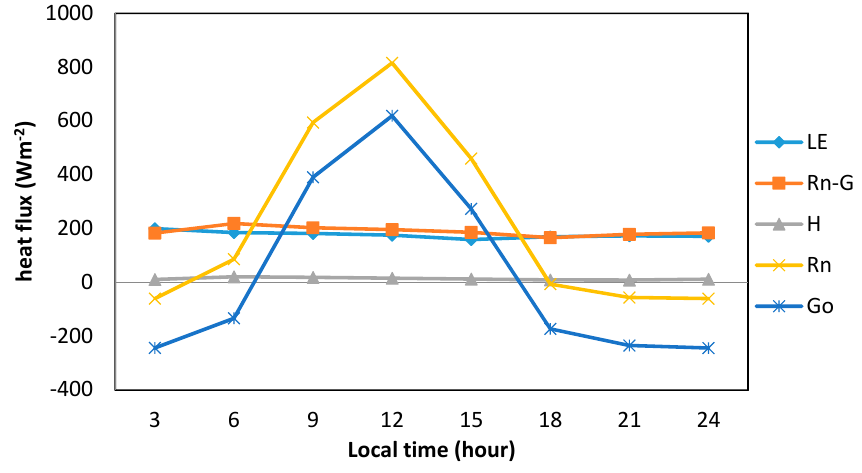
Figure 4. Heat fluxes and available energy over Indian Ocean 1 January 2010.